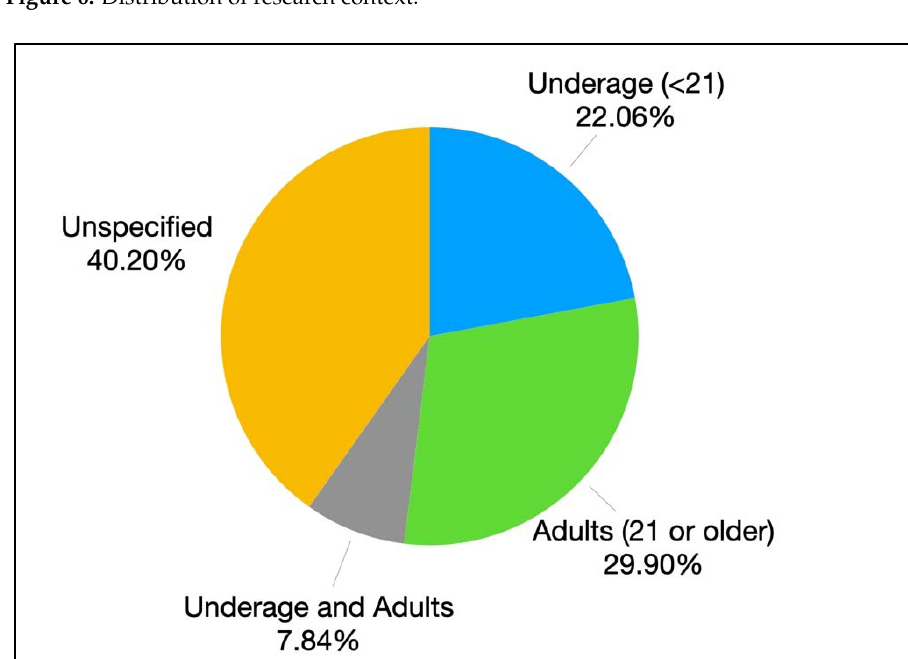
Figure 7. Distribution of studies included in systematic review by samples age group.